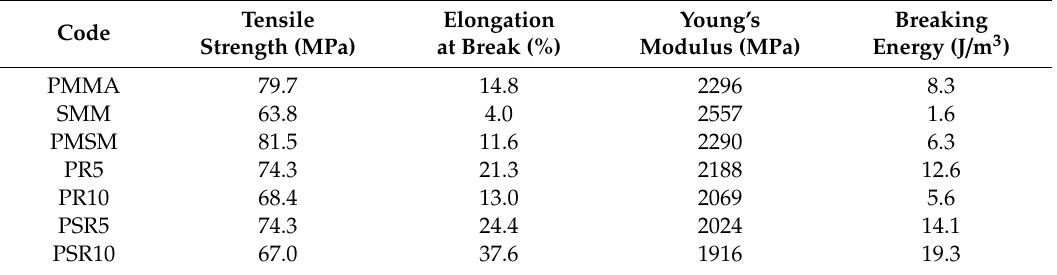
Figure 6. Stress–strain curves of the matrix resins, PMMA/PR blends, and PMMA/SMM/PR blends. Table 2. Mechanical properties of the matrix resins, PMMA / PR blends, and PMMA / SMM / PR Table 2. Mechanical properties of the matrix resins, PMMA/PR blends, and PMMA/SMM/PR blends.